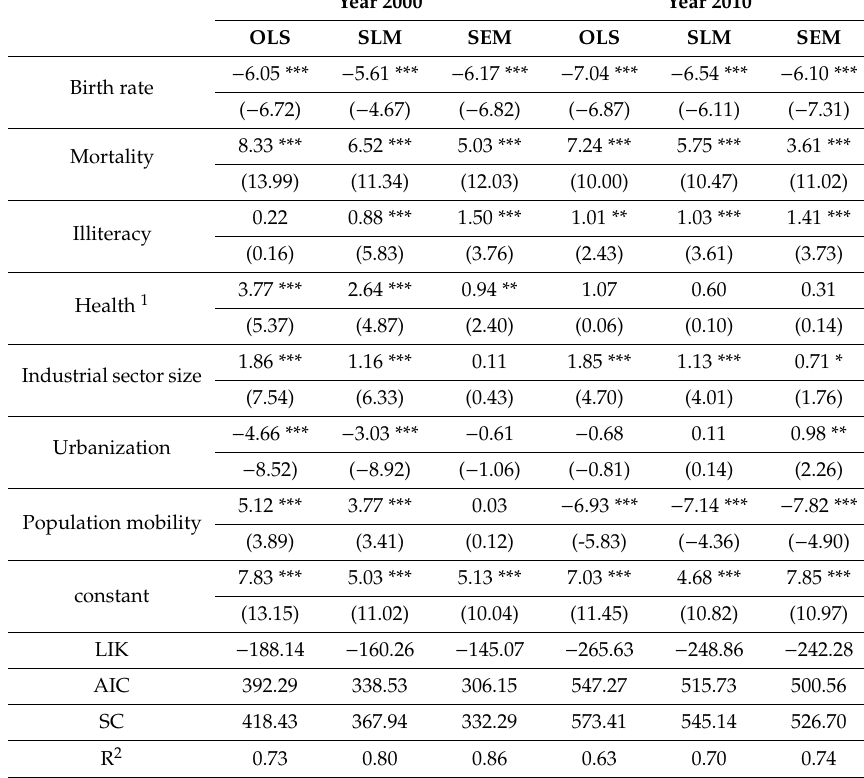
Table 2. Spatial econometric estimation